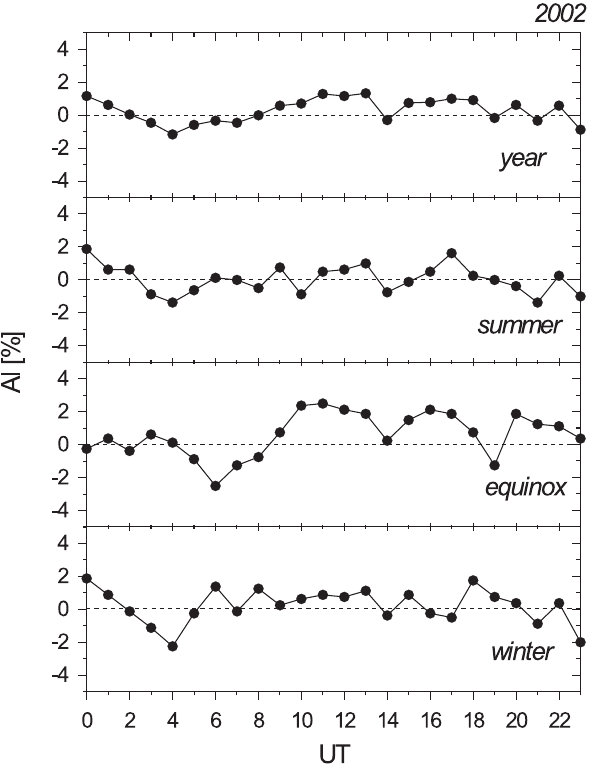
Fig. 5. Diurnal variations of mean AI values for the full year 2002 and different seasons of this year (summer, equinox, and winter).